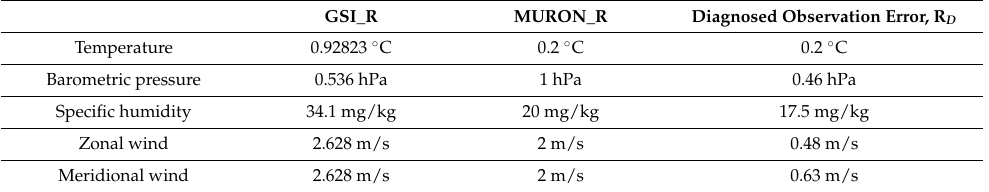
Table 1. Observation errors of GSI conventional ocean surface observation (GSI_R), MURON (MURON_R), and diagnosed observation error from Desrozier’s method ( R D